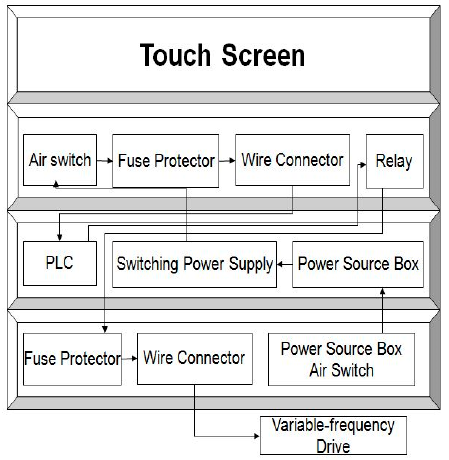
Figure 6. Design chart of the S-PLC employed in this study. PLC, programmable logic